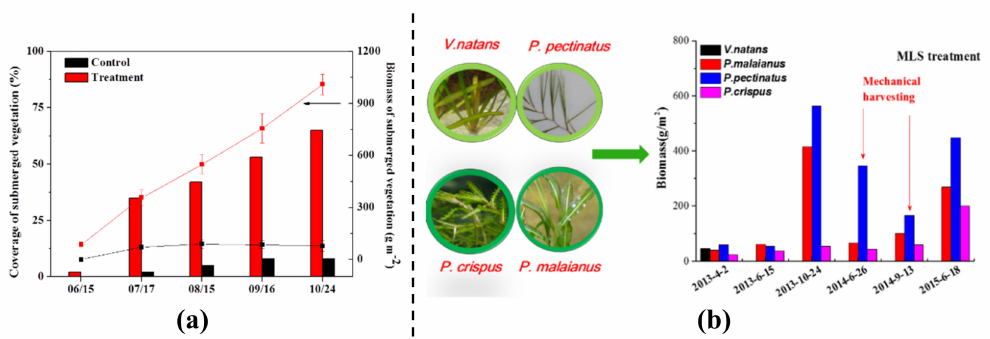
Figure 11. Ecological responses monitoring experiment at Cetian research site after MLS treatment.